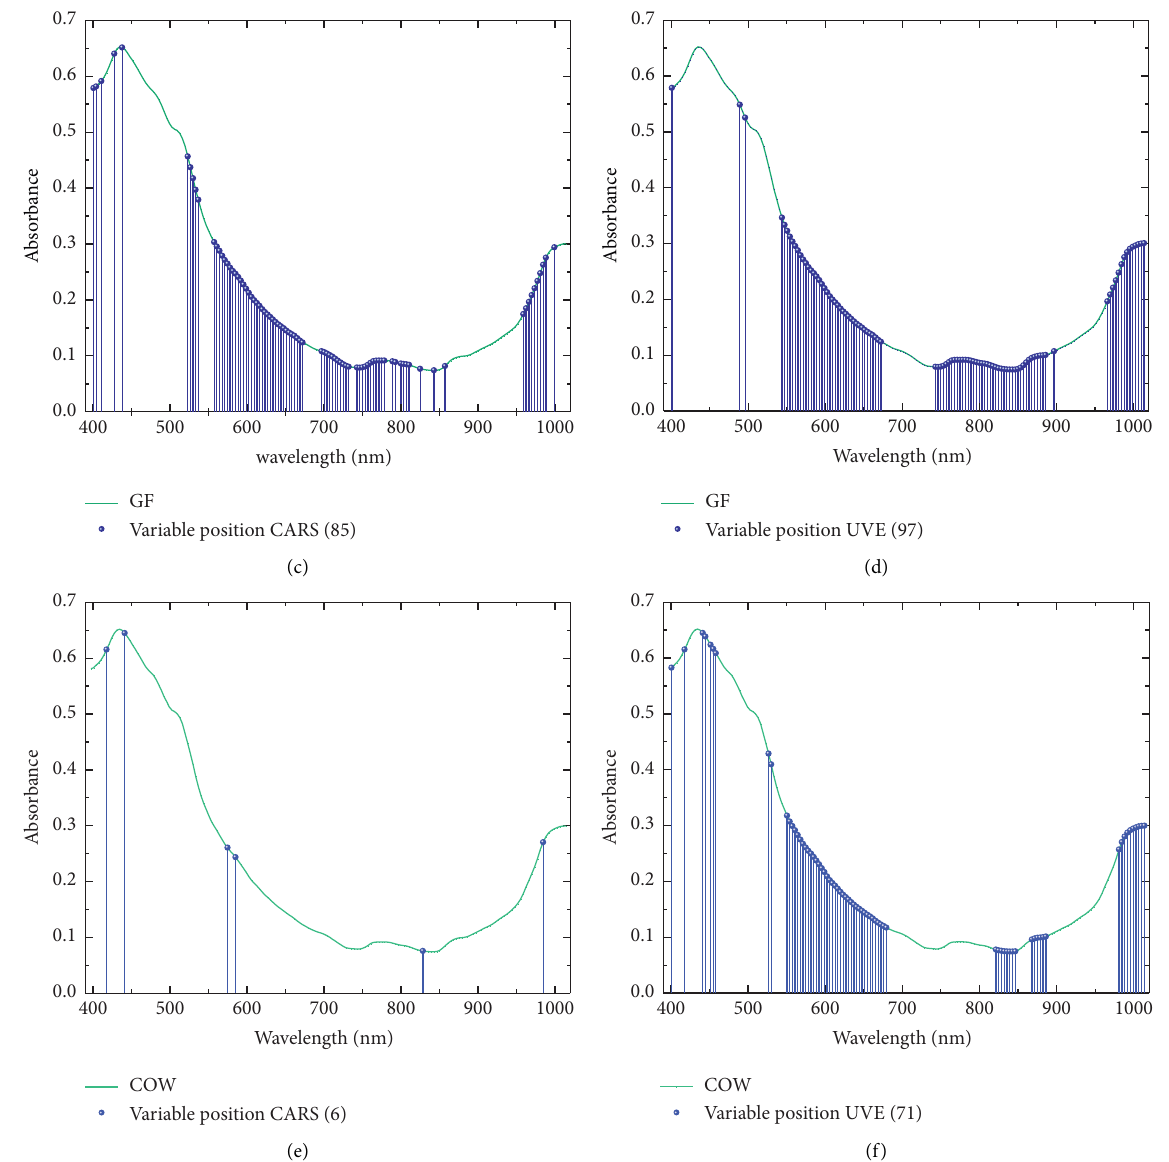
Figure 9: Results of the selection of A spectra characteristic wavelengths based on CARS and UVE. Characteristic wavelength of the A-RAW spectra selected based on (a) CARS and (b) UVE. Characteristic wavelength of the A-GF spectra selected based on (c) CARS and (d) UVE. Characteristic wavelength of the A-COW spectra selected based on (e) CARS and (f)